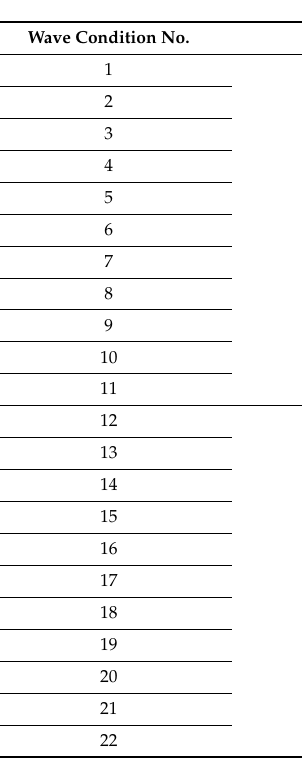
Figure 9. ( a ) Average reflection coefficients and ( b ) average transmission coefficients of all tested random sea states. Table 3. Random wave conditions in Figure 9.